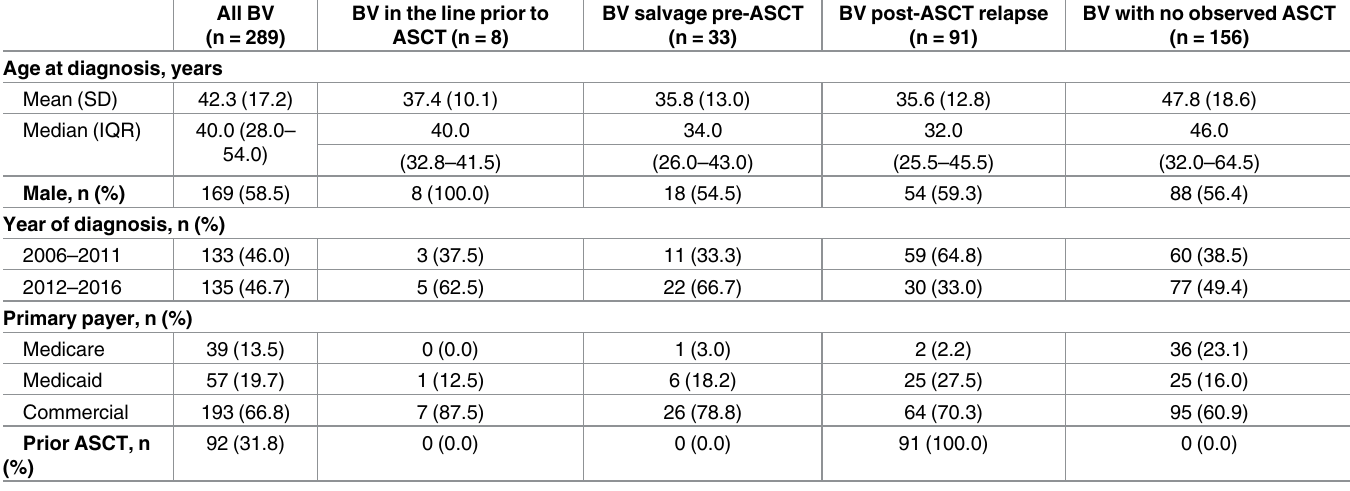
Table 1. Demographic characteristics of the 289 patients in the MarketScan database with (cid:21) 6 months of enrollment before and after BV initiation. All BV (n =